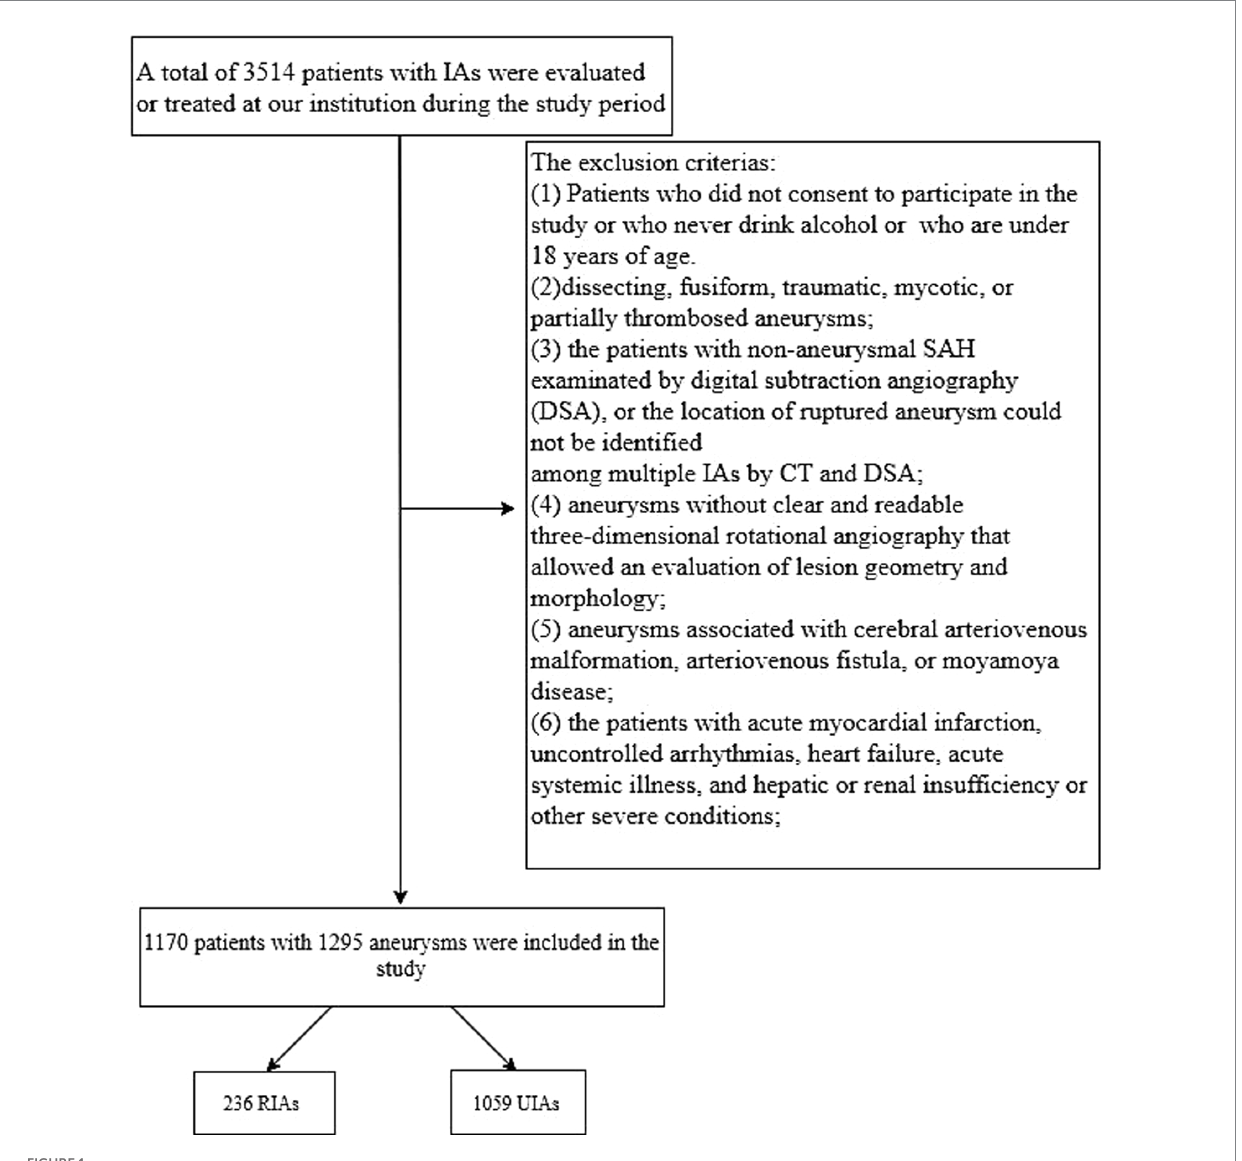
FIGURE 1 Study flowchart. IA, intracranial aneurysm; SAH, subarachnoid hemorrhage; CT, computed tomography; DSA, digital subtraction angiography; RIA, ruptured intracranial aneurysm; UIA, unruptured intracranial